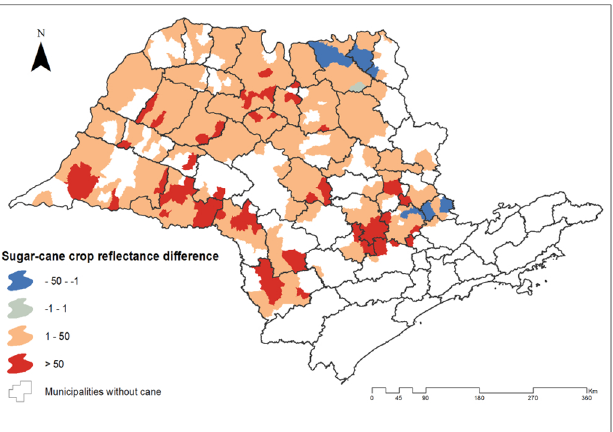
Fig 3. Sugarcane crops pixel abundance difference between the 2007 – 2012 and 2000 – 2006 periods. Negative (blue) values indicate that the pixel abundance was higher at 2000 – 2006 period and positive (red) values indicate that the pixel abundance value was higher at the 2007 – 2012